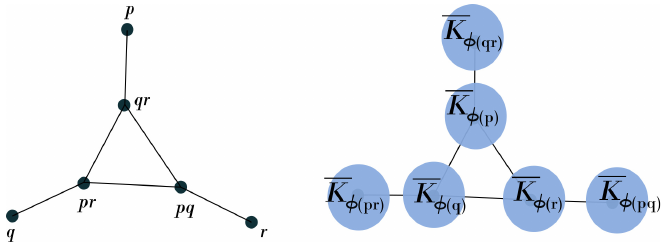
Figure 2. Proper divisor graph Υ pqr and zero-divisor graph Γ ( Z pqr )